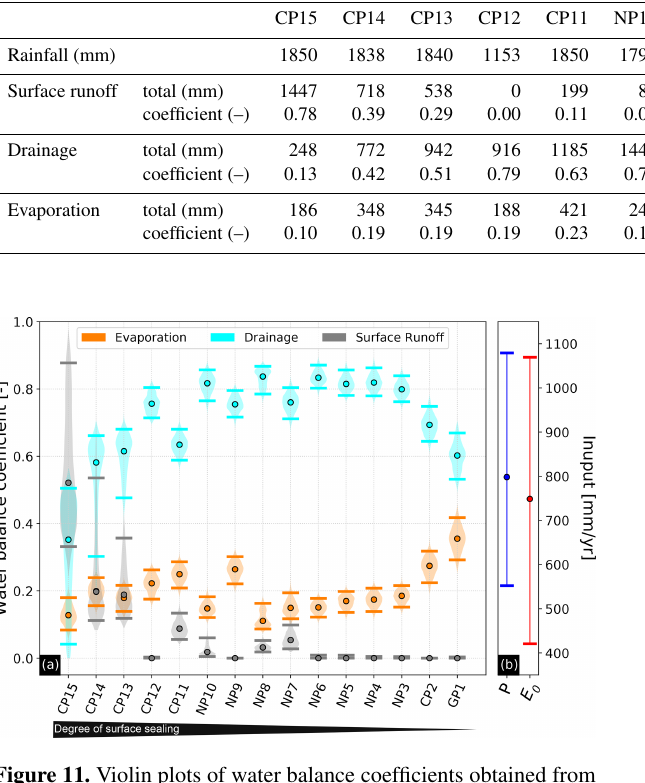
Figure 11. Violin plots of water balance coefficients obtained from the 10000 Monte Carlo simulations (a) and the range of the consid- ered variability of the climatic input (b) . Points indicate the median of all runs, while horizontal lines represent the 5th and 95th per- centiles of the